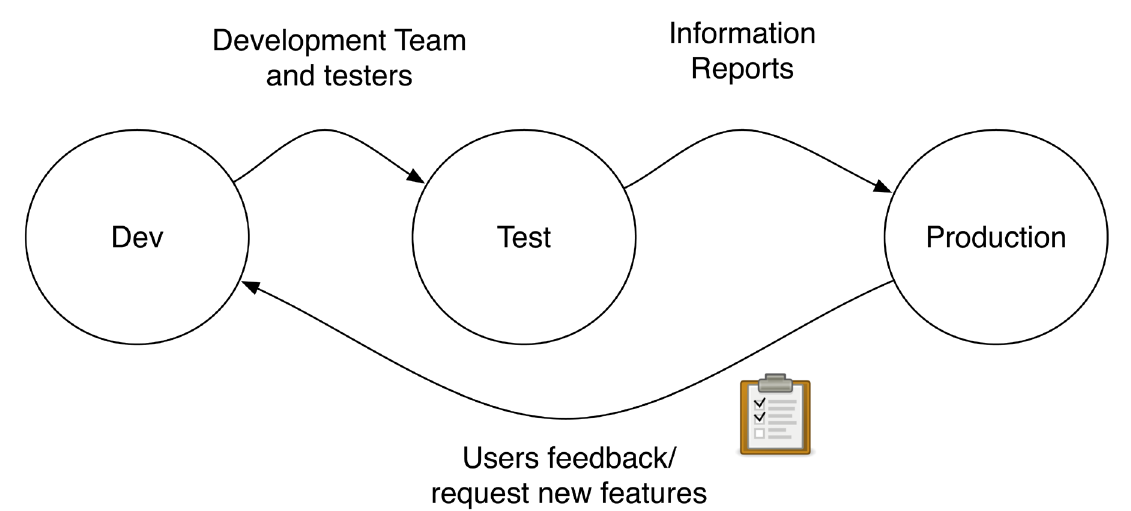
Figure 3. The deployment of each new release should follow three release management steps: development, testing and